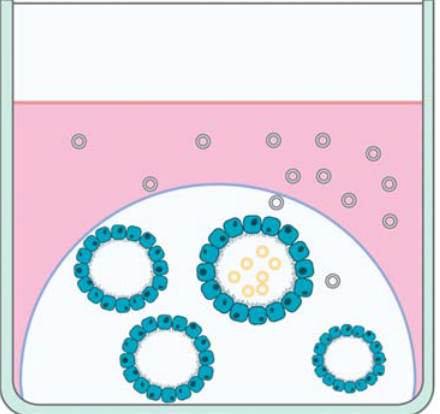
Figure 2. Depiction of extracellular vesicles (EVs) secreted by the apical (yellow EVs) and basal (green EVs) aspects of organoids in cell culture.